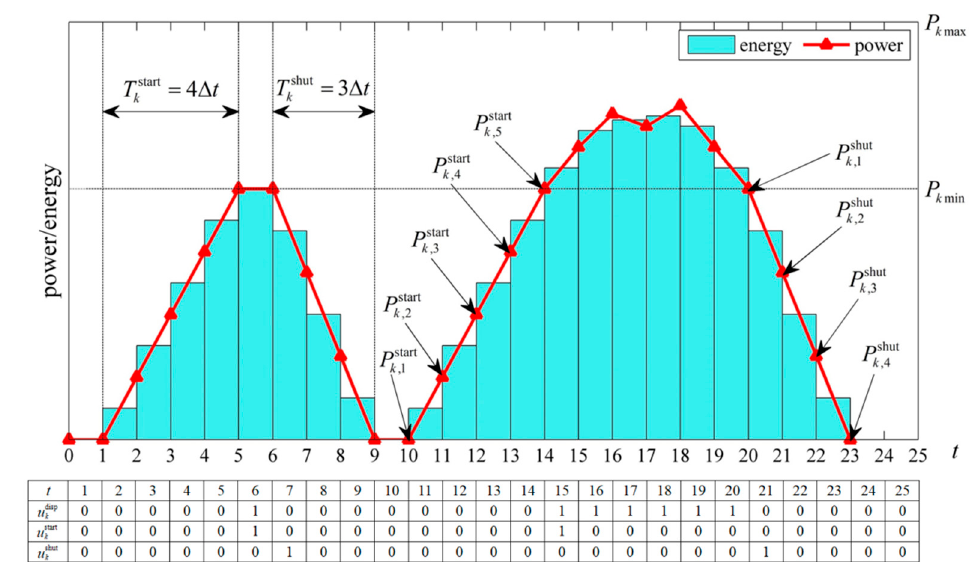
Figure 1. Illustration of state variables, start-up and shut-down trajectories.